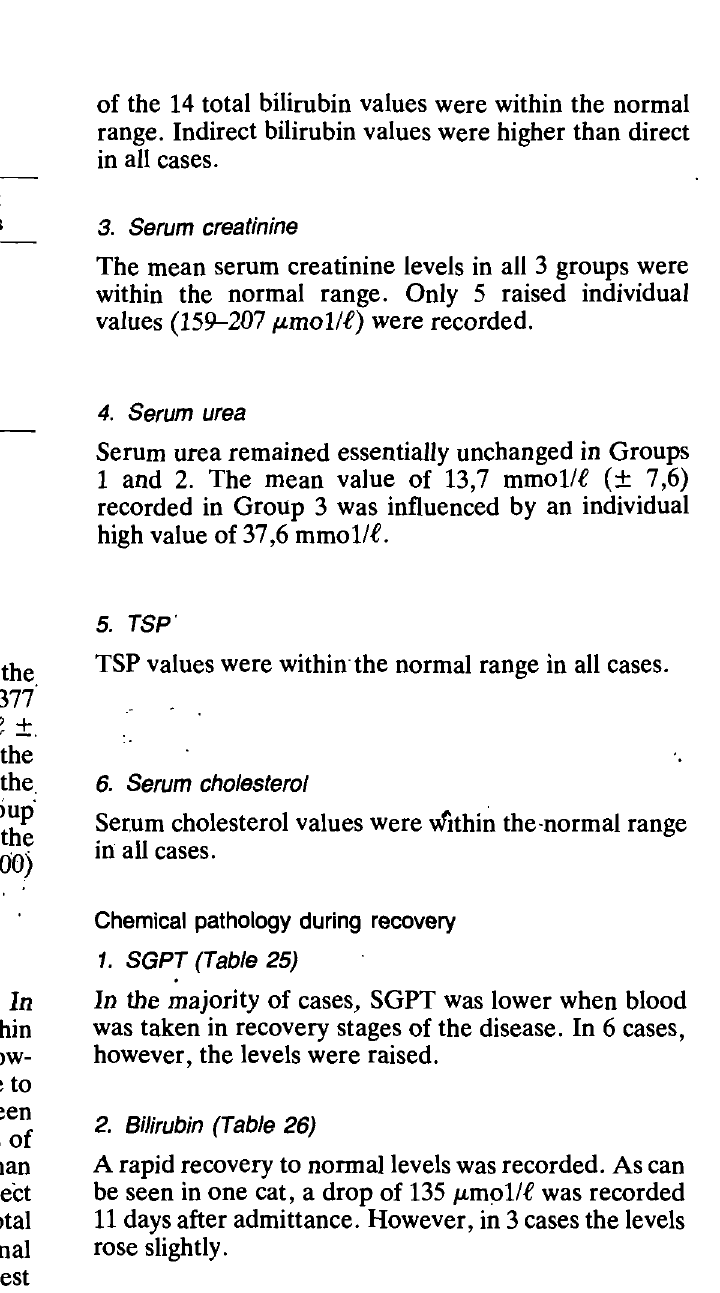
Table 24: AGE, HAEMATOLOGY AND CHEMICAL PATHOLOGY OF 70 CLINICAL CASES OF B. FELIS INFECTION AT INITIAL